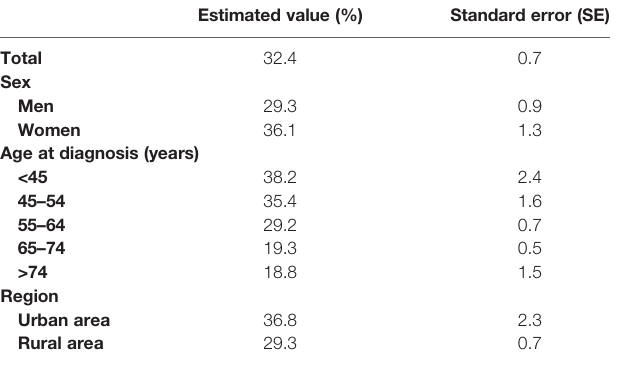
TABLE 2 | Survival of liver cancer patients during 2014 – 2018 in Taizhou, eastern